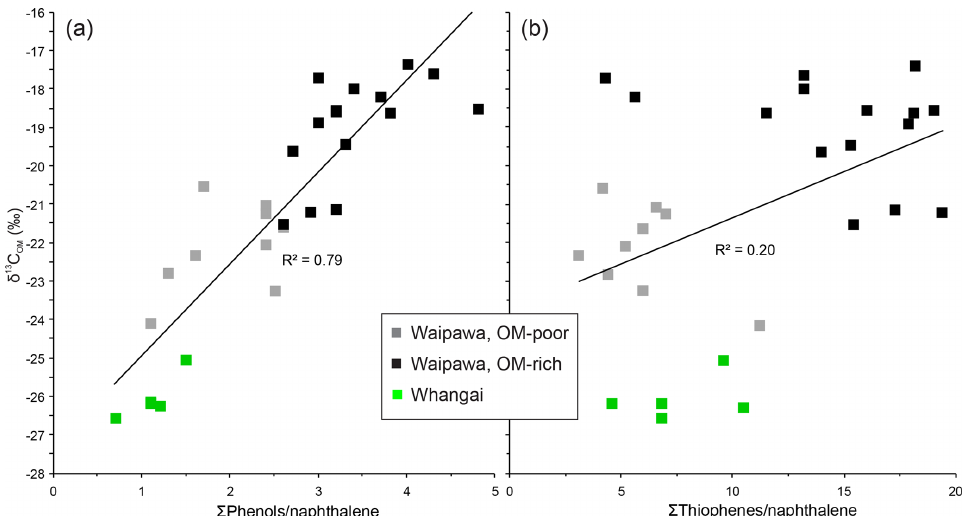
Figure 7. Correlation of δ 13 C OM with (a) phenol and (b) thiophene abundances relative to naphthalene for the OM-rich (TOC > 2wt%) and OM-poor (TOC < 2wt%) Waipawa facies and Whangai facies in the Taylor White section. Naphthalene is used to normalize these compounds because it is a generic compound independent of source. Linear regressions include all